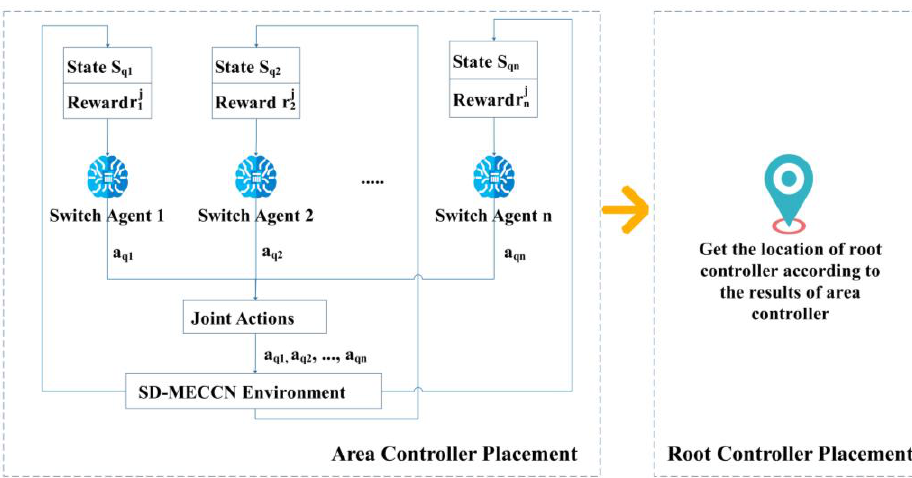
Figure 2. The procedure of the proposed solution.